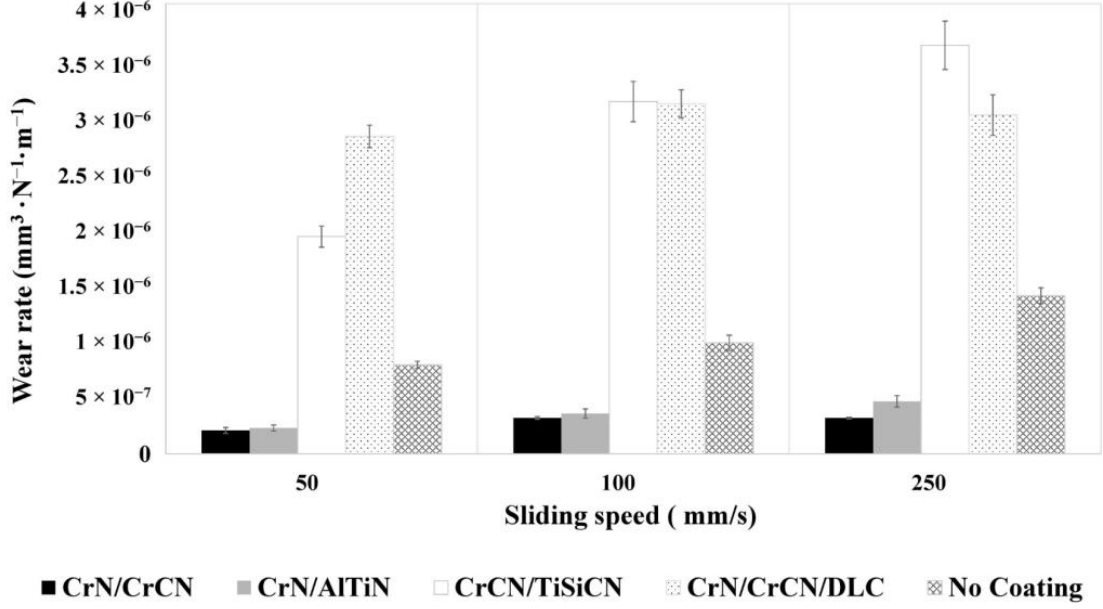
Figure 13. Wear rate of uncoated and coated carbide substrates.